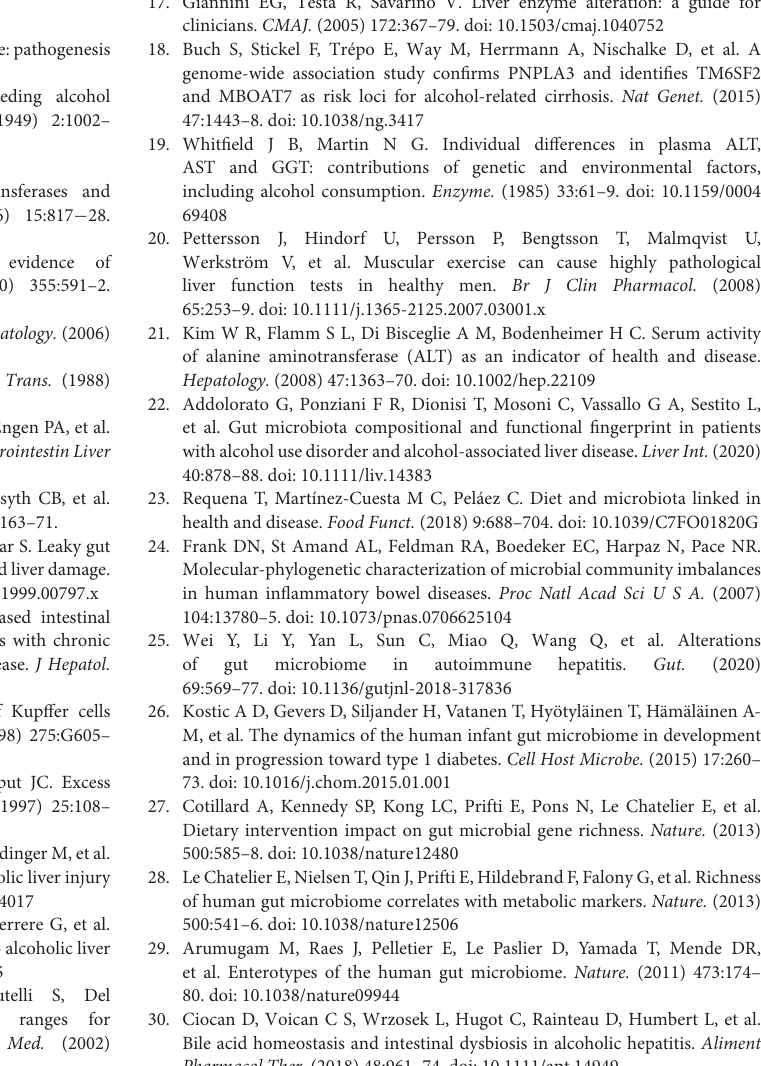
Supplementary Figure 1 | Pearson distance and Bray–Curtis distance illustrated significant differences in the microbial community for pathway beta diversity. (A) Principal coordinate analysis (PCOA) diagram by the Pearson distance. (B,C) The first and second principal components are based on the Pearson distance. (D) PCOA diagram by the Bray–Curtis distance. (E,F) The first and second principal components are based on the Bray–Curtis distance. Supplementary Table 1 | Statistically differential species and metabolic pathways related to the drinking case